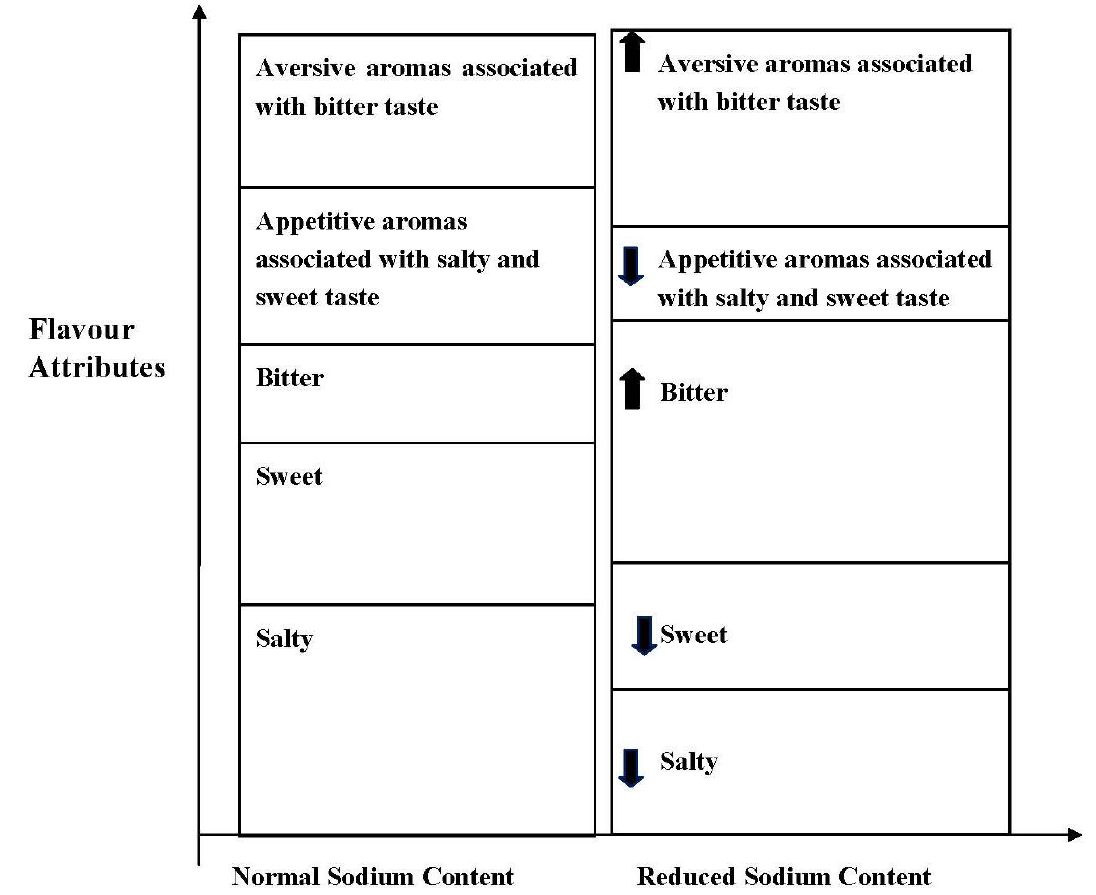
Figure 4. Influence of sodium reduction on flavor. The height of the boxes making up total flavor reflects intensity of the named attribute in standard or reduced sodium food